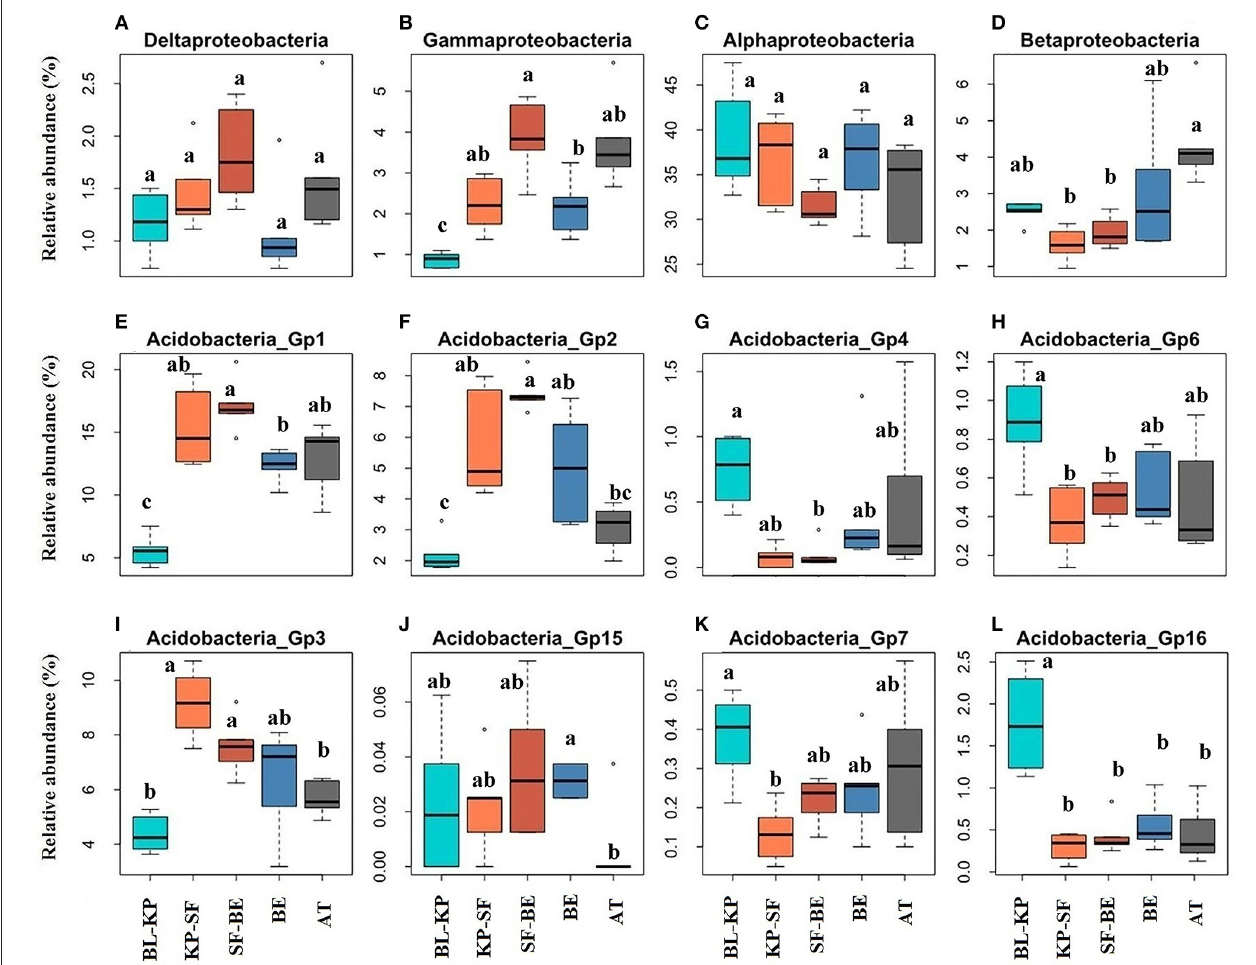
FIGURE 4 | The elevational distribution patterns of the relative abundances of specific bacterial classes within the phylum of Acidobacteria and Proteobacteria. The classes within Proteobacteria are Deltaproteobacteria (A) , Gammaproteobacteria (B) , Alphaproteobacteria (C) and Betaproteobacteria (D) . Acidobacteria_Gp1 (E) , Acidobacteria_Gp2 (F) , Acidobacteria_Gp4 (G) , Acidobacteria_Gp6 (H) , Acidobacteria_Gp3 (I) , Acidobacteria_Gp15 (J) , Acidobacteria_Gp7 (K) and Acidobacteria_Gp16 (L) belong to the phylum of Acidobacteria. Significantly different ( t -test, P adjust < 0.05) groups are denoted with different letters. BL-KP, Broad leaf-Korean pine mixed forest; KP-SF, Korean pine-spruce fir forest; SF-BE, Spruce Fir- Betula ermanii forest; BE, Betula ermanii forest; AT, Alpine tundra.